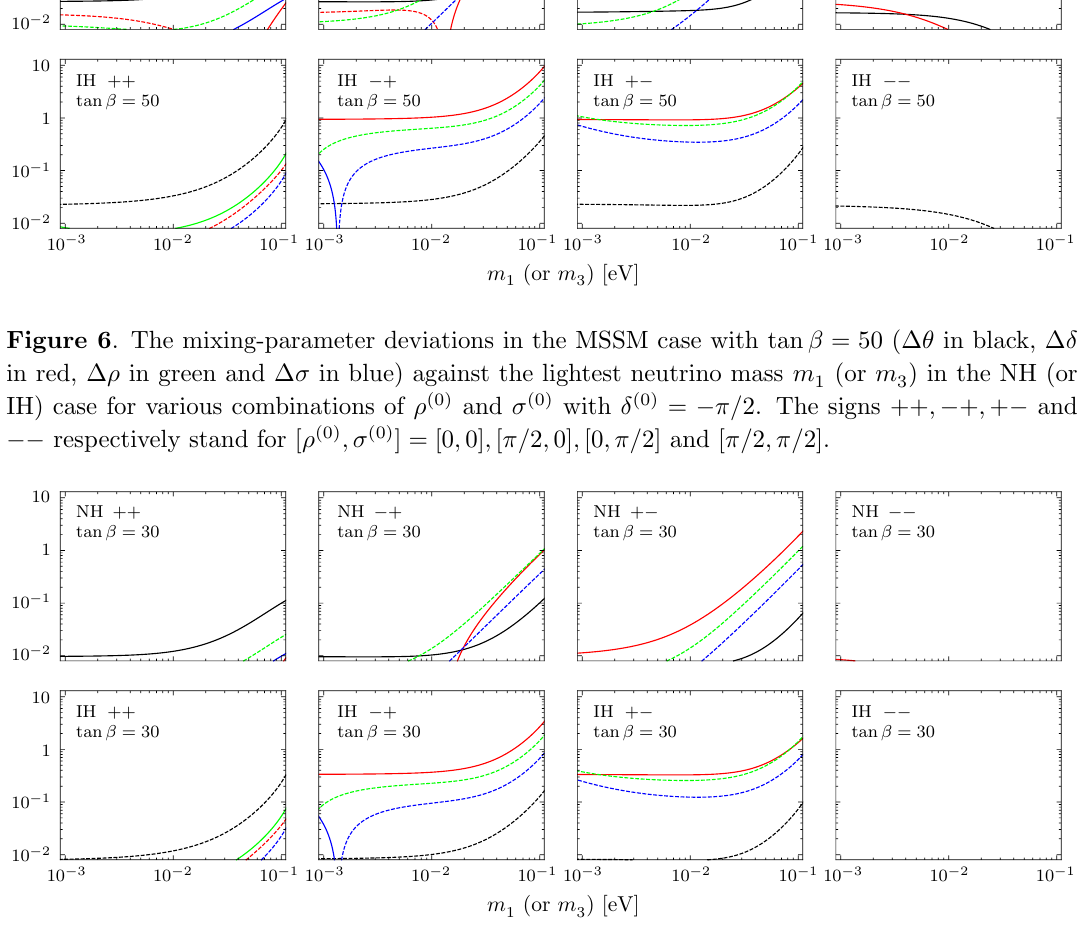
Figure 7 . The mixing-parameter deviations in the MSSM case with tan (cid:12) = 30 ((cid:1) (cid:18) in black, (cid:1) (cid:14) in red, (cid:1) (cid:26) in green and (cid:1) (cid:27) in blue) against the lightest neutrino mass m IH) case for various combinations of (cid:26) (0) and (cid:27) (0) with (cid:14) (0) = (cid:0) (cid:25)= 2. The signs ++ ; (cid:0) + ; + (cid:0)